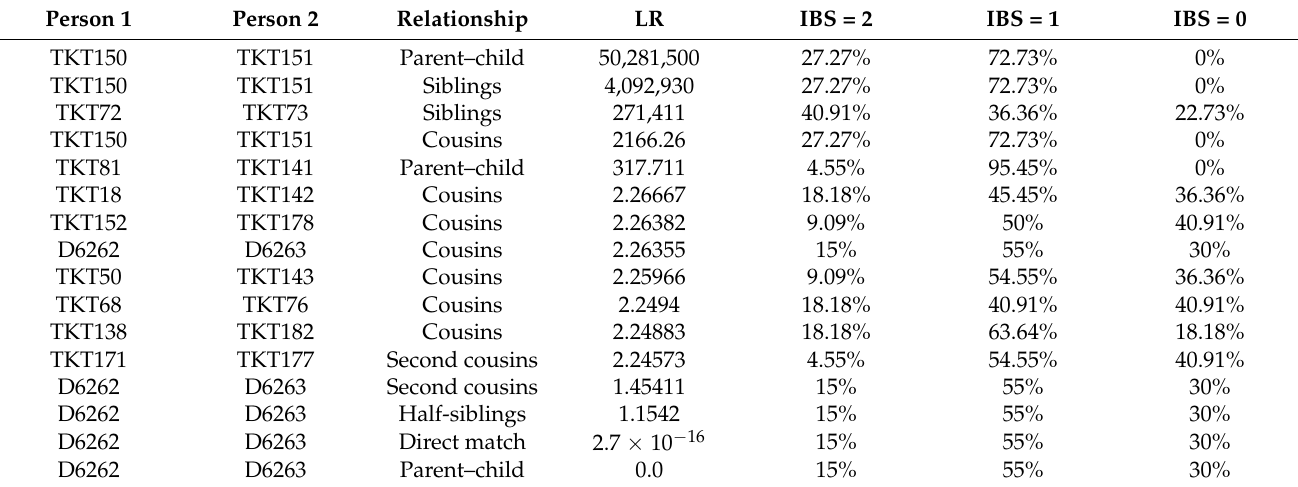
Table 1. Likelihood ratio and identical-by-state analysis for relative